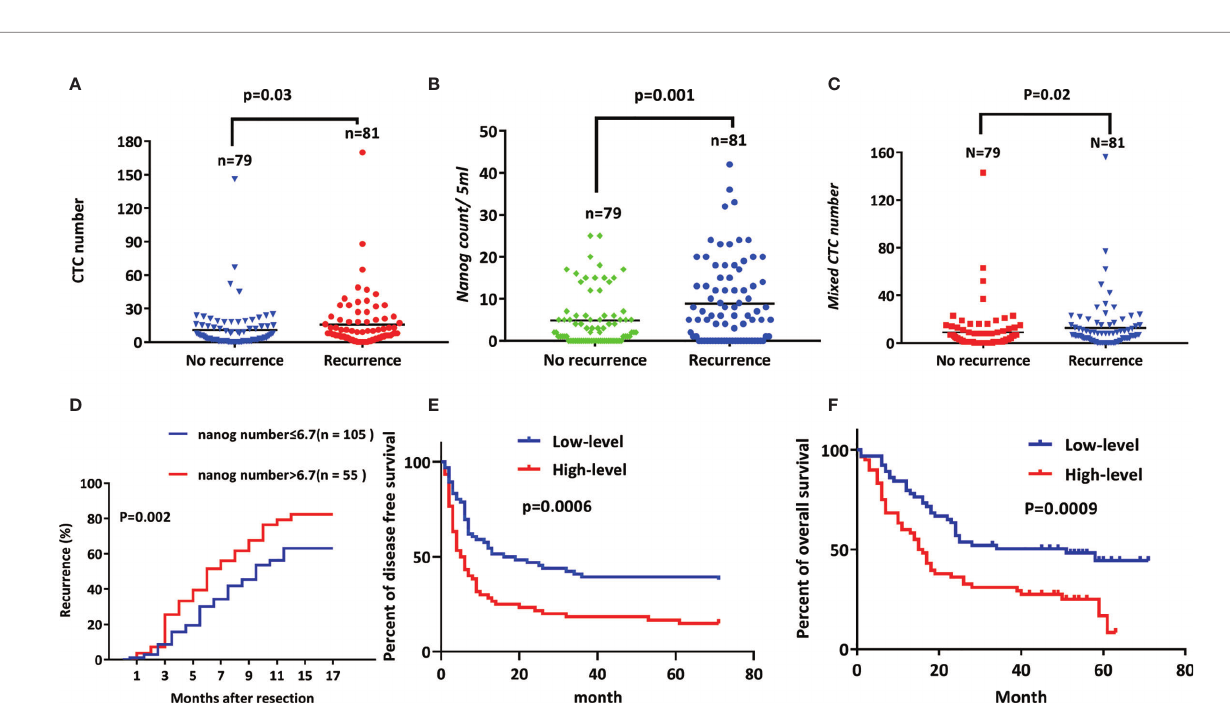
FIGURE 5 | Nanog + CTC expression is positively correlated with recurrence (A) CTC number, (B) Nanog count, (C) The higher the expression of Mixed CTC number and Nanog, the higher the early recurrence rate of liver cancer; (D) Kaplan – Meier estimates of disease-free survival (E) (p<0.001) and overall (F) (p<0.001) survival of 160 HCC patients with high-level Nanog ( ≥ 500 m m2/ fi eld) and low-level Nanog (< 500 m m2/ fi